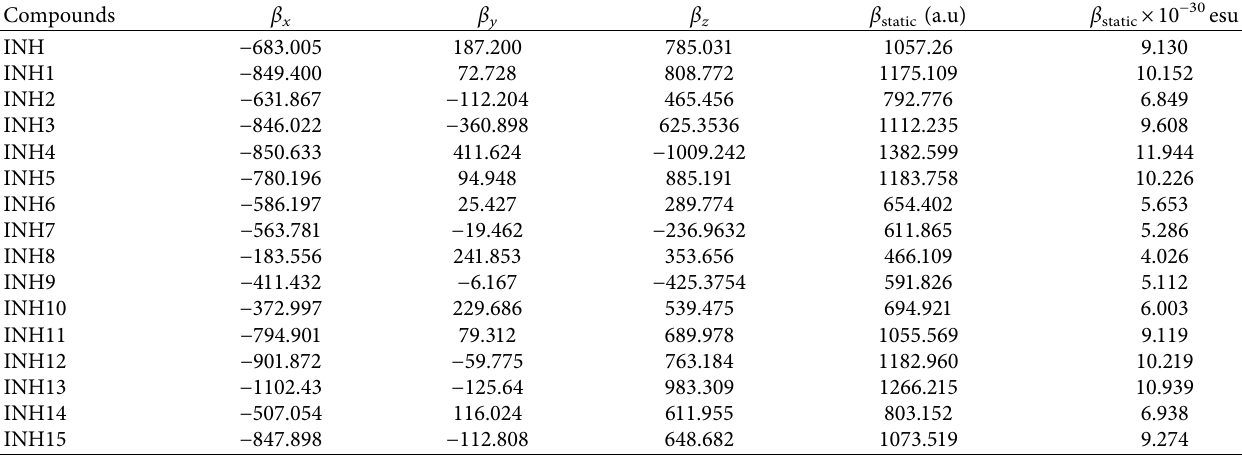
� 0 at the B3LYP-D/6-311G (d,p) level of